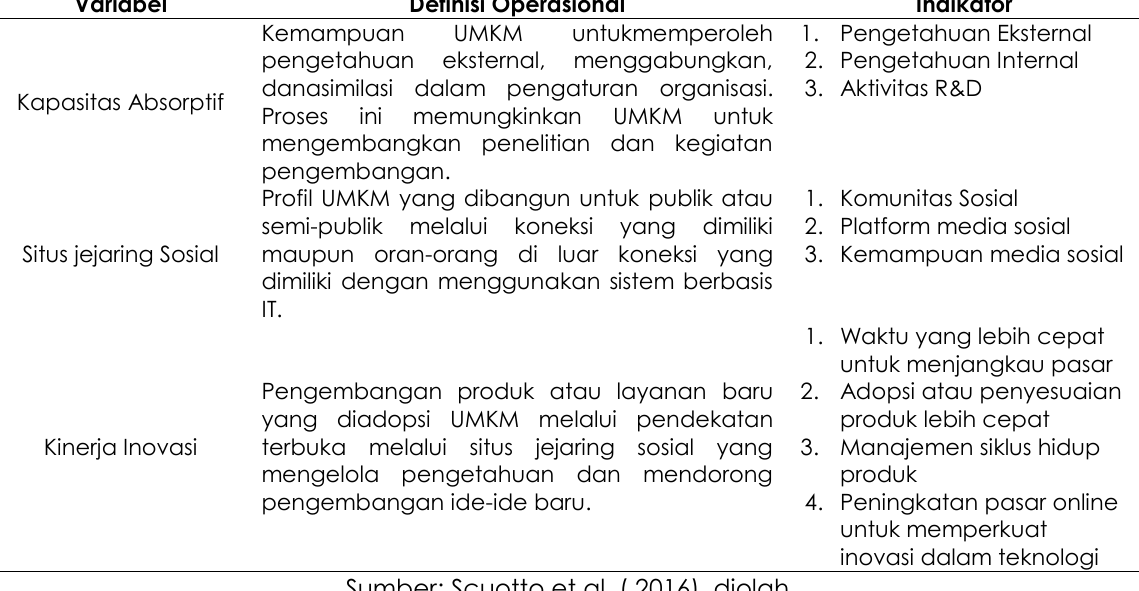
Table 1. Pengukuran Kapasitas Absorptif, Situs Jejaring Sosial dan Kinerja